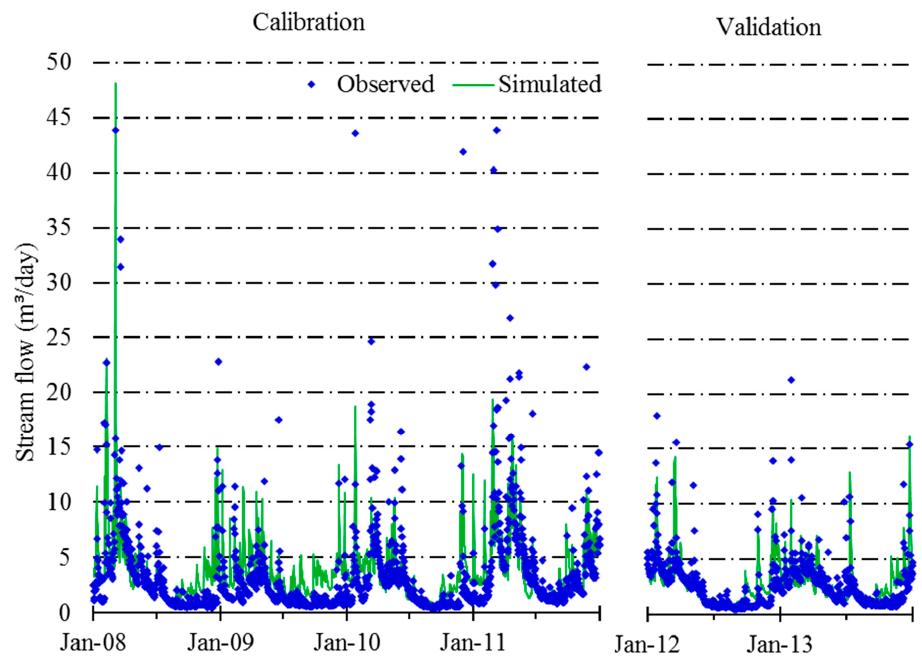
Figure 3. Hydrograph during calibration (2008 − 2011) and validation (2012 − 2013) periods.